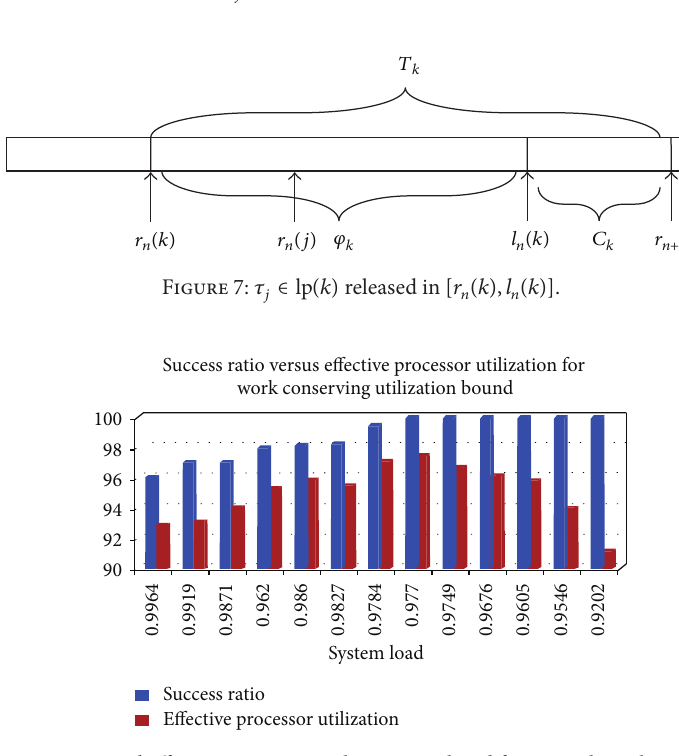
Figure 8: Success ratio and effective processor utilization analyzed for example, task set using UML-RT. Table 4: Analysis of work conserving utilization bound algorithm for various set of 𝑇 𝑖